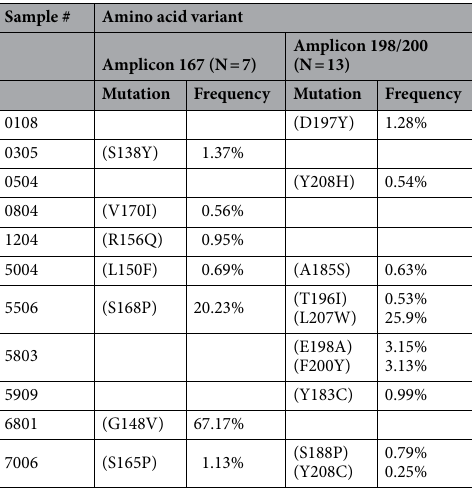
Table 1. Allelic variants corresponding to amino acid changes within the isotype-1 β-tubulin gene of Necator